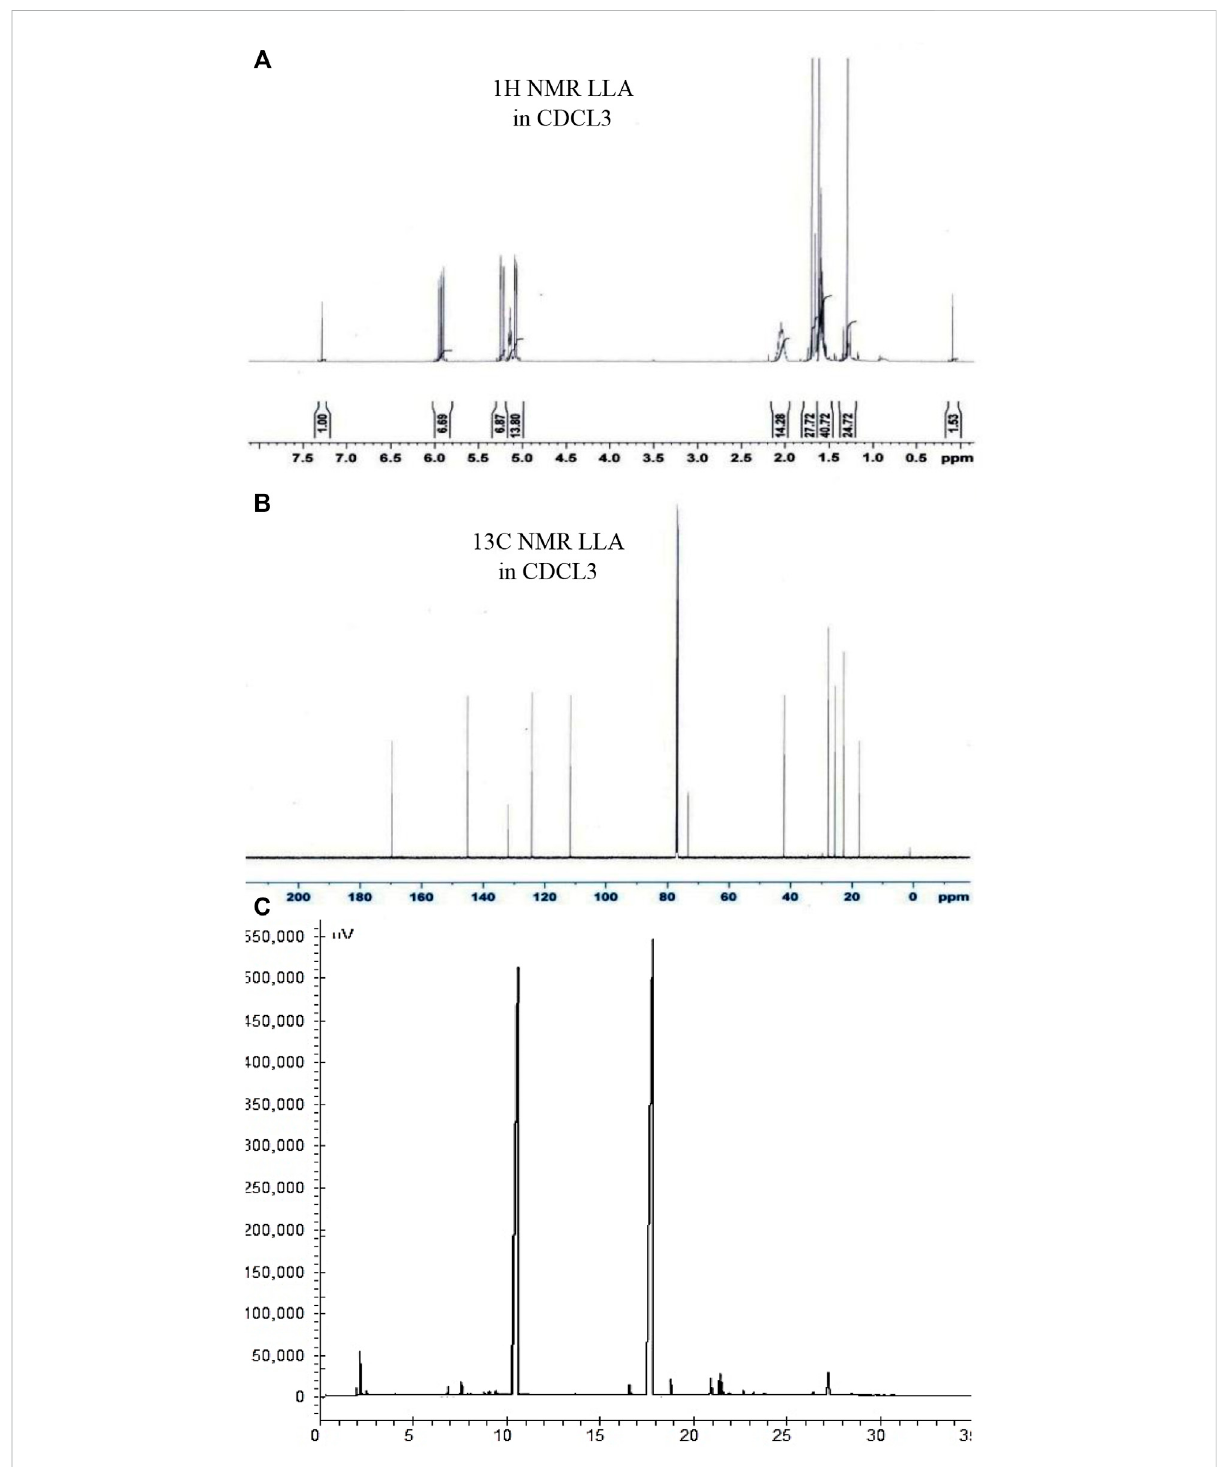
FIGURE 5 Characterizing the phyto-combination of linalool and linalyl acetate by NMR and GC analysis. Pictures (A) , (B) , and (C) depict 1 H NMR, 13 C NMR spectrum, and GC chromatogram of linalool + linalyl acetate combination (1:1 w/w), respectively.